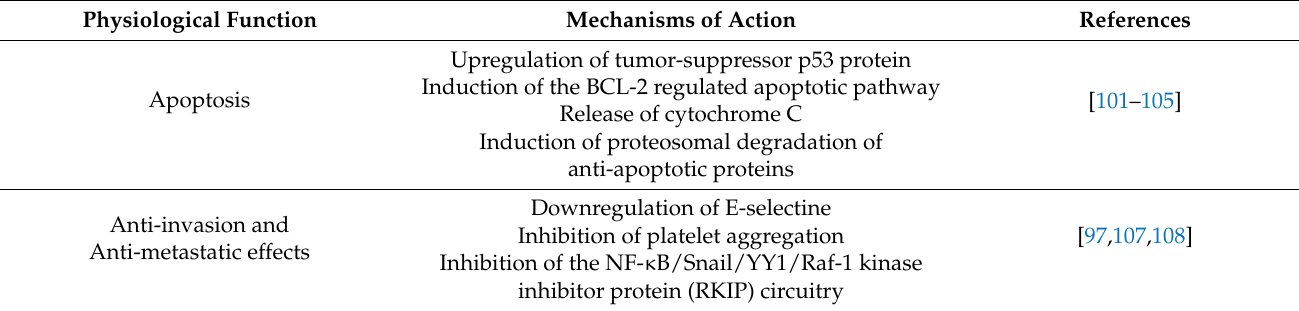
Table 3. Cancer-inhibiting physiological function of high concentration of